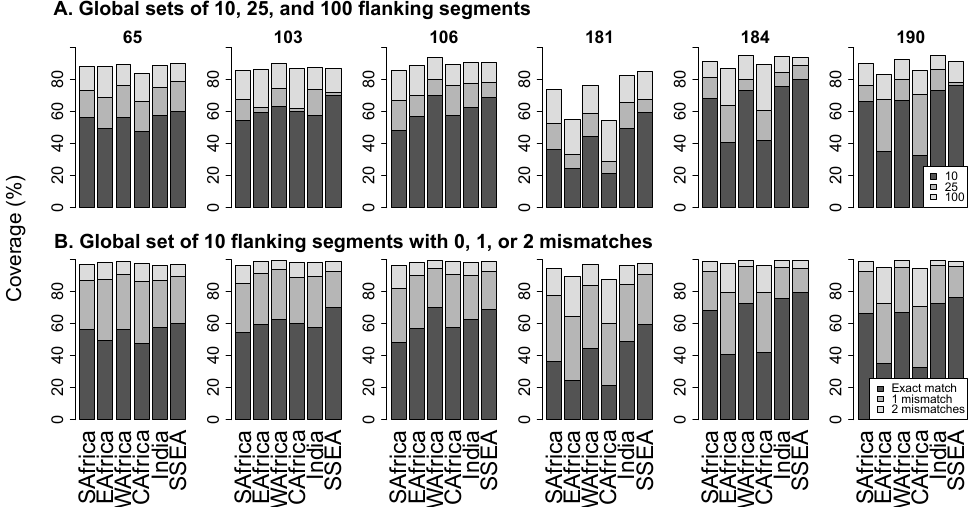
Figure 3. Panel ( A ) shows the proportion of sequences that exactly match the 10 (black bar), 25 (dark grey), and 100 (light grey) most common universal flanking segments overall. Panel ( B ) shows the proportion of sequences that exactly match (black bar), differ by one nucleotide (dark grey), or differ by two nucleotides (light grey) from the 10 most common universal flanking sequences overall. Abbreviations: SAfrica, Southern Africa; EAfrica, East Africa; WAfrica, West Africa; CAfrica, Central Africa; SSEA, South and Southeast Asia. Figure 4A contains stacked bar plots that show the proportions of flanking segments that exactly match the 10, 25, and 100 most common regional flanking segments. The proportion of exact matches for the regional set of 10 flanking segments ranged from a mean of 58% at position 181 to 82% at position 190. The proportion of exact matches for the 100 most common flanking sequences ranged from a mean of 88% at position 181 to 98% at position 184.